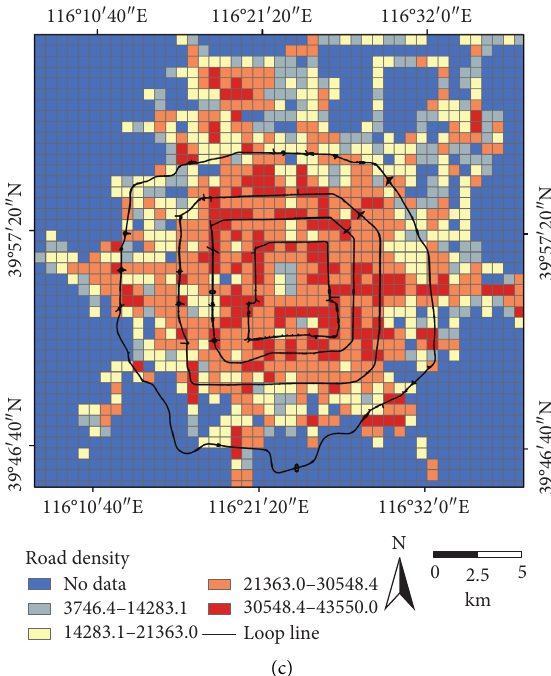
Figure 12: Characteristics of the regional road networks: (a) local wayfinding performance level; (b) road complexity; and (c) road density. Table 6: Correlation between local WPL and road complexity and density. Road complexity Road density